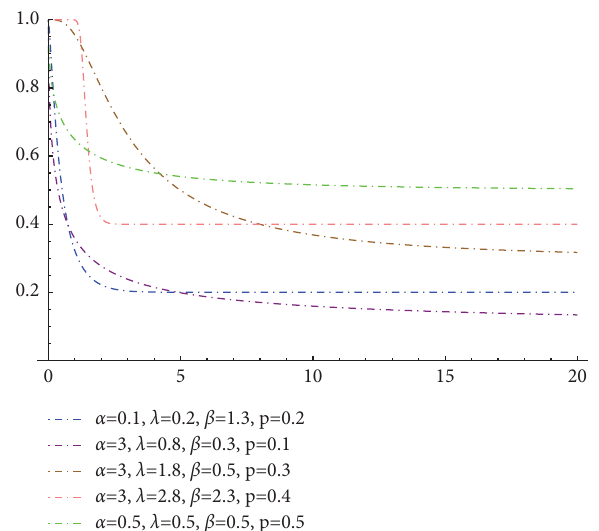
Figure 4: Te survival function of the PGEcr/GeTNH model for diferent parameters values. c , c ⊤ � ( c , c , . . . , c ) is a vector of In Table 1, u � x ⊤ s i 0 1